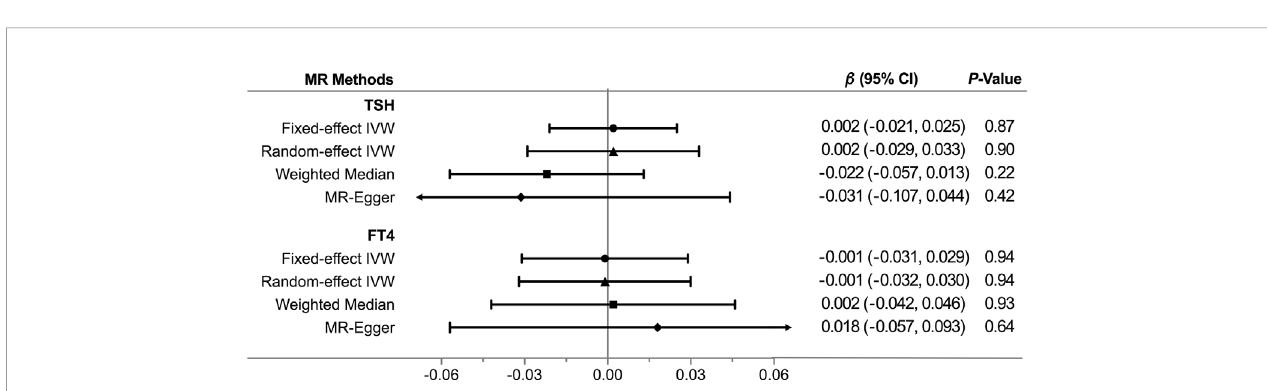
FIGURE 3 | Comparisons of Mendelian randomization results by different methods. CI, Con fi dence interval; FT4, free thyroxine; IVW, inverse variance weighted; MR, Mendelian randomization; TSH, thyroid stimulating hormone.